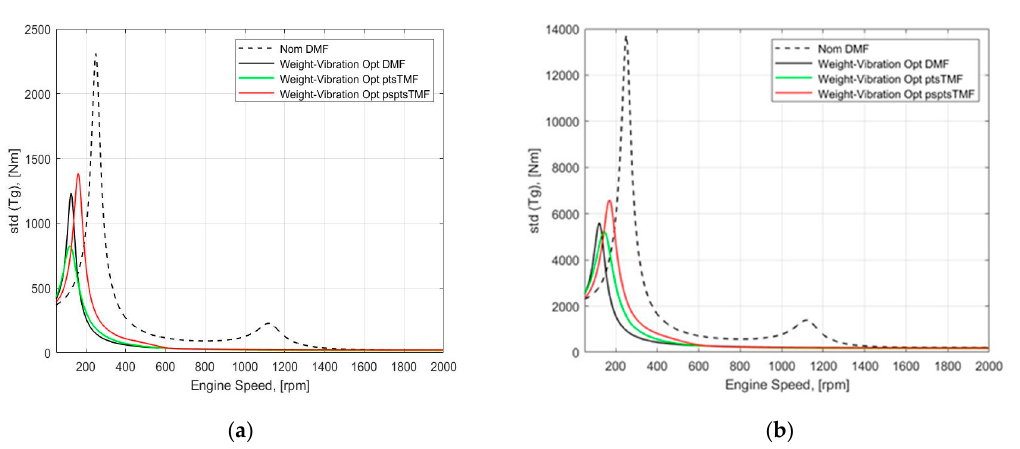
Figure 4. Engine speed history of standard deviation of the torques at the transmission input shaft for the DMF with nominal values of design parameters (12) and for vibration absorbers with obtained optimizeddesignparameters: ( a )for T m = 300Nm, a e = 500Nm; ( b )for T m = 3000Nm, a e =